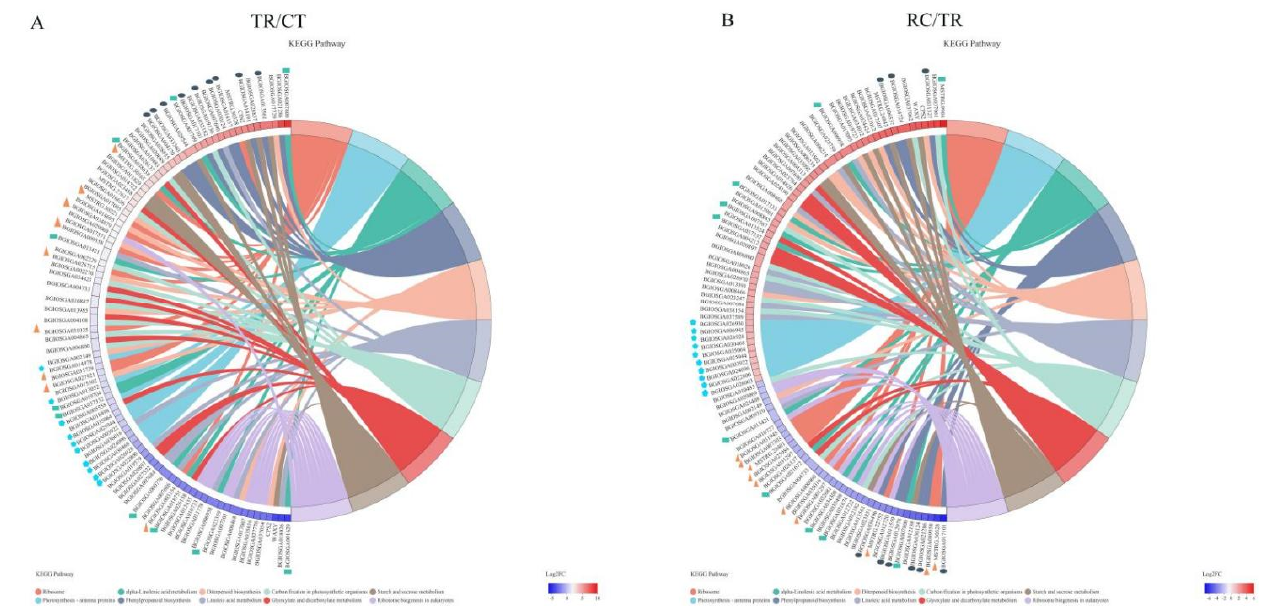
Figure 5. ( A ) The pathways were significantly enriched by KEGG analysis from normal temperature to chilling. ( B ) The pathways were significantly enriched by KEGG analysis from chilling recovery to normal temperature. The triangles, ellipses, pentagons and rectangles demonstrated the top enriched genes for KEGG in the ribosome, phenylpropanoid biosynthesis, photosynthesis-antenna proteins and linoleic acid metabolism, respectively.